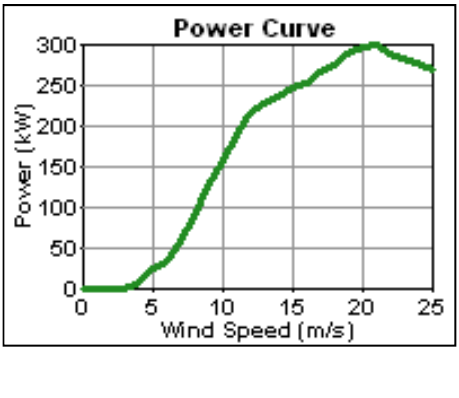
Figure 3. Fuhrländer 250 power curve.